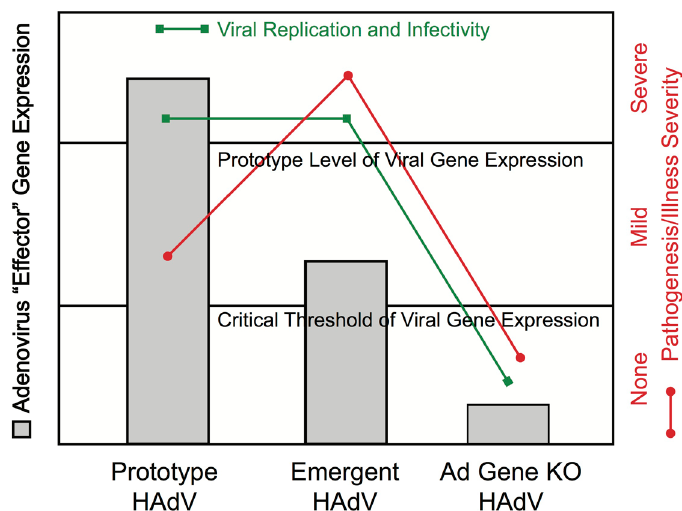
Figure 2. “Critical threshold” viral gene expression model of emergent adenoviral immunopathogenesis. When expression of the adenoviral “effector” gene is normal (left gray bar, Prototype human adenovirus [HAdV]), viral replication and infectivity (green line) are at the rates associated with prototype virus infection, and pathogenesis and illness severity (red line) are mild. Conversely, when viral effector gene expression falls below the critical threshold needed for normal viral replication and infectivity, as would be observed with a gene knockout (KO) virus (right gray bar, Ad Gene KO), there would be inadequate virus generated for infection transmission and little (or no) pathogenesis and no clinical illness. With more virulent, emergent adenoviral strains, expression of the adenoviral effector gene would fall below the normal expression level observed with the prototype strain but would stay above the critical threshold expression level needed for viral replication, infectivity, and infection transmission. Because of the loss-of-function phenotype of the emergent virus that would result from reduced expression of the effector gene, there would be reduced infection-related immunomodulation and, consequently, increased virus- induced immunopathogenesis and more severe clinical